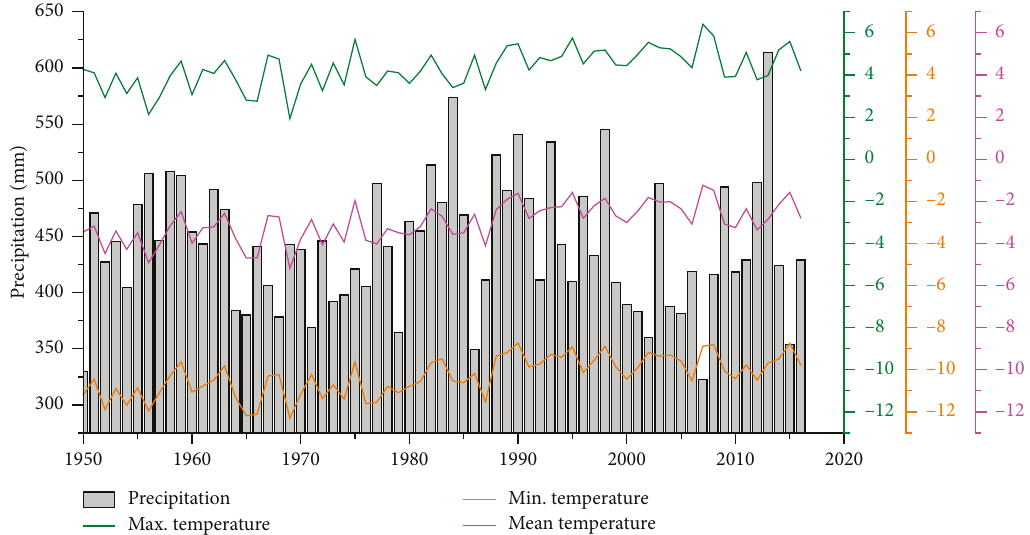
Figure 2: Spatial distribution of climatic factors for annual precipitation, annual maximum temperature, annual minimum temperature, and annual mean temperature from 1950 to 2010, from the sampling plots for Larix gmelinii and Betula platyphylla in Daxing’anling Mountain, Inner Mongolia, respectively. Total stem biomass per plot was summed for all plots to average biomass and carbon stock of the individual plot. Then, we converted it to tons per hectare (tons/ha).